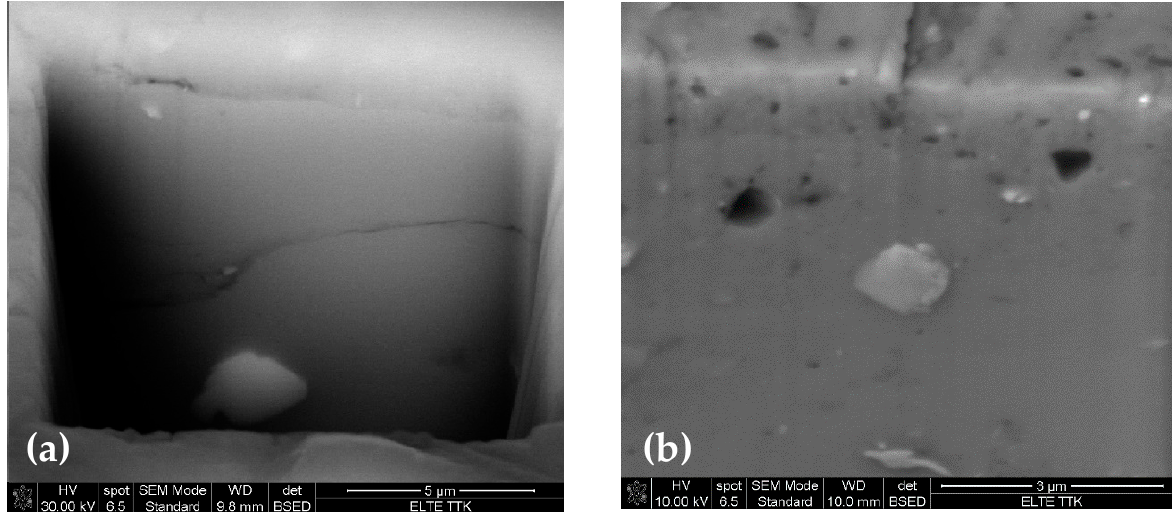
Figure 8. SEM-FIB images taken from the inner surface of the ion-milled notches corresponding to ( a ) central and ( b ) perimeter region of a Mg 65 Ni 20 Cu 5 Y 10 amorphous HTP-disk [116].